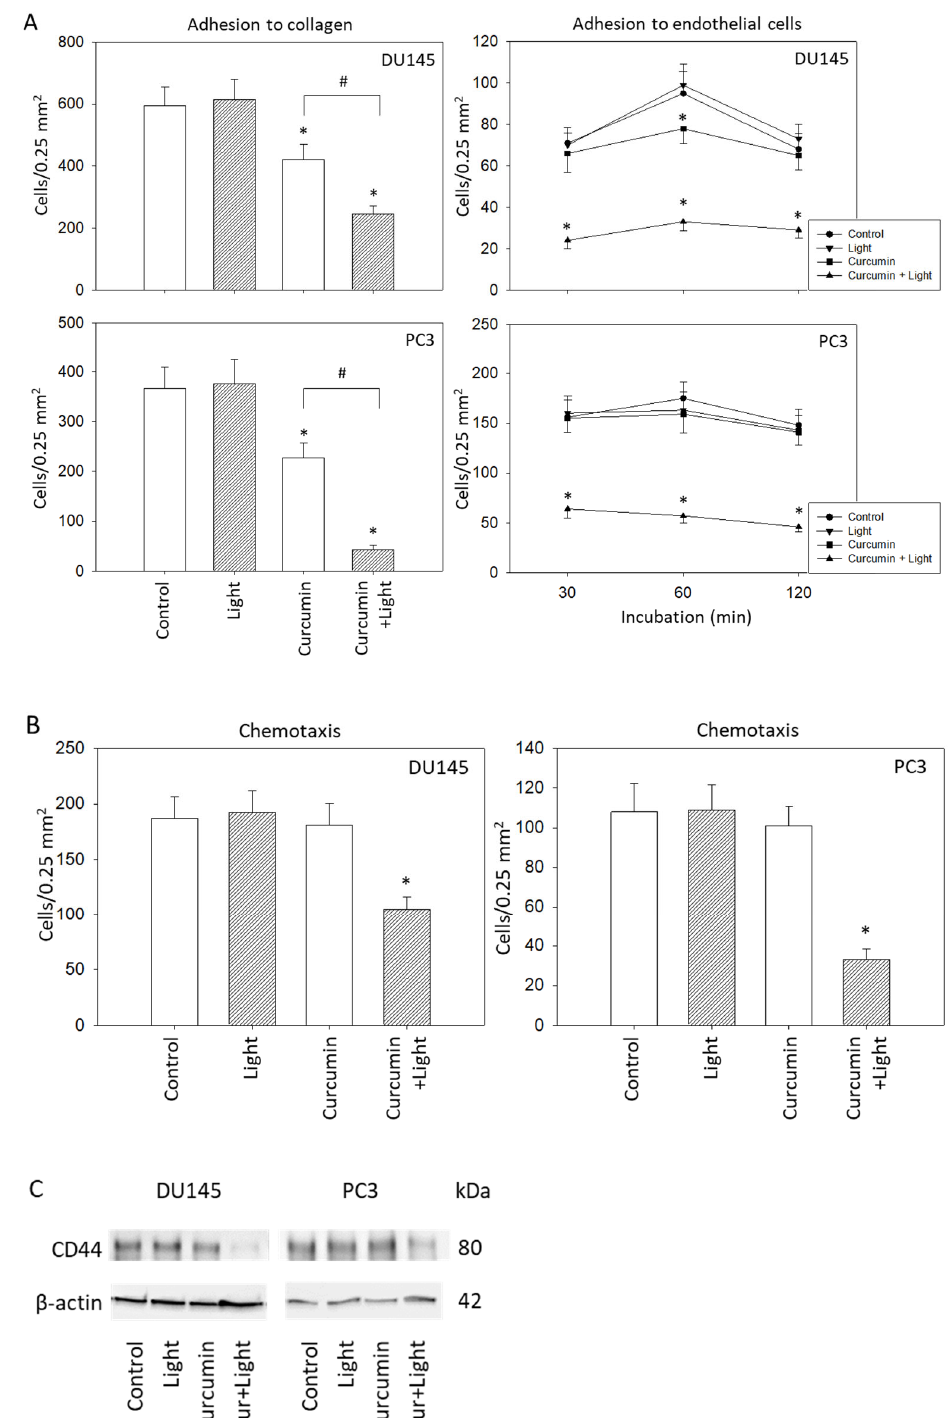
Figure 6. ( A ): Adhesion characteristics of DU145 and PC3 cells following exposure to visible light (5 min at 1.65 J/cm 2 ), curcumin (0.2 µ g/mL) or light alone, or to the curcumin–light combination. Controls depict untreated cells. The left panel of ( A ) shows cell binding to immobilized collagen, the right panel of ( A ) shows cell adhesion to endothelial cells. ( B ): Motility of treated versus non-treated DU145 and PC3 cells. Mean values were calculated from five counts; error bars indicate standard deviation; * indicates significant difference to the control; # indicates significant difference between the curcumin treated and the curcumin–light treated cells. ( C ): CD44 expression in DU145 and PC3 cells in the presence of visible light, curcumin, or curcumin+light (Cur + Light). Controls remained untreated. One representative result is